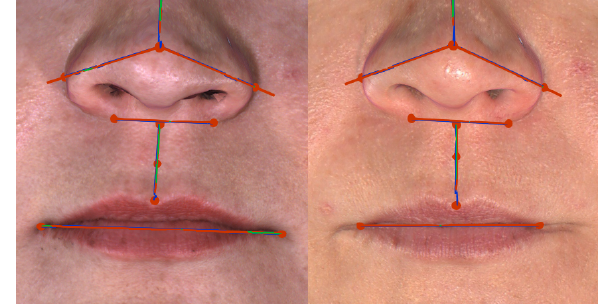
Figure 5. Inaccurate placement by an assessor of the labial fissue measure in the Vectra H1 image (right) while placement is accurate in the 3dMD image